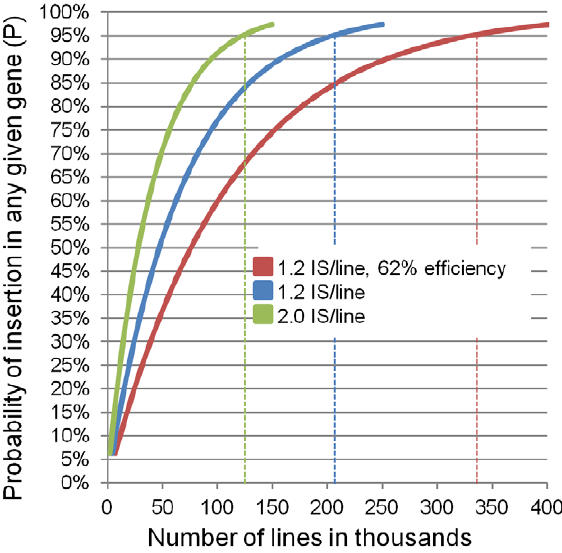
Figure 7. Estimated numbers of T-DNA mutants needed to saturate the Brachypodium genome. The number of T-DNA mutants needed for saturation mutagenesis of the Brachypodium genome is estimated using the formula {P=1 2 (1 2 [x/g]) n }. P is the probability of finding an insertion in a particular gene; g is the genome size in kb; x is the average gene length in kb; n is the number of T-DNA insertions needed. The red line shows the number of lines estimated using our current sequencing efficiency of identifying FSTs in 62% of the lines tested with an average of 1.2 IS/line. The blue and green lines illustrate estimates based on identifying FSTs in 100% of the lines with an average of 1.2 IS/line or 2.0 IS/line, respectively. Dashed lines indicate the number of lines needed for P=0.95 for each efficiency of identifying insertion sites.